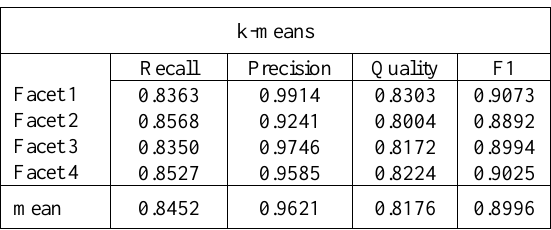
Table 2 . Evaluation metrics for k-means method.